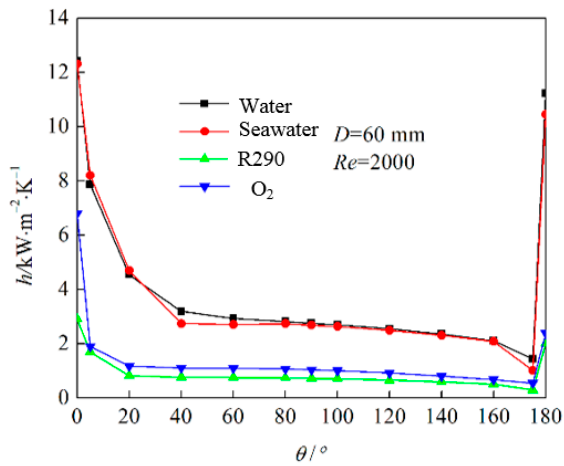
Figure 13. Local heat transfer coefficient h on the horizontal round tube.